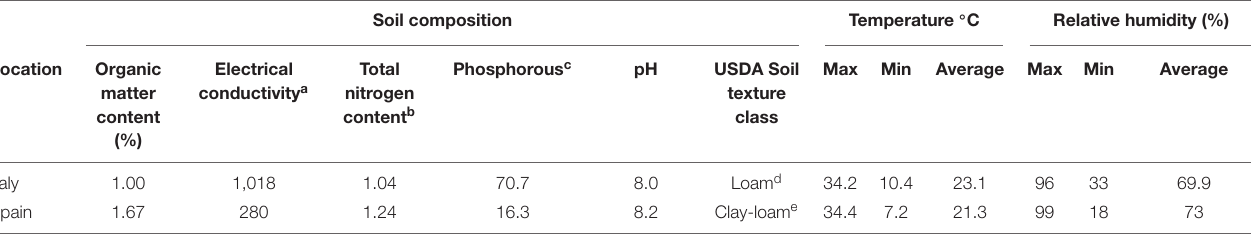
TABLE 1 | Pedoclimatic conditions of the two organic fields: (i) the experimental station of the Research Centre for Vegetable and Ornamental Crops (CREA) located in Monsampolo del Tronto, Italy; (ii) a private farm located in Alcàsser, province of Valencia, Spain. Soil composition Temperature ◦ C Relative humidity (%)